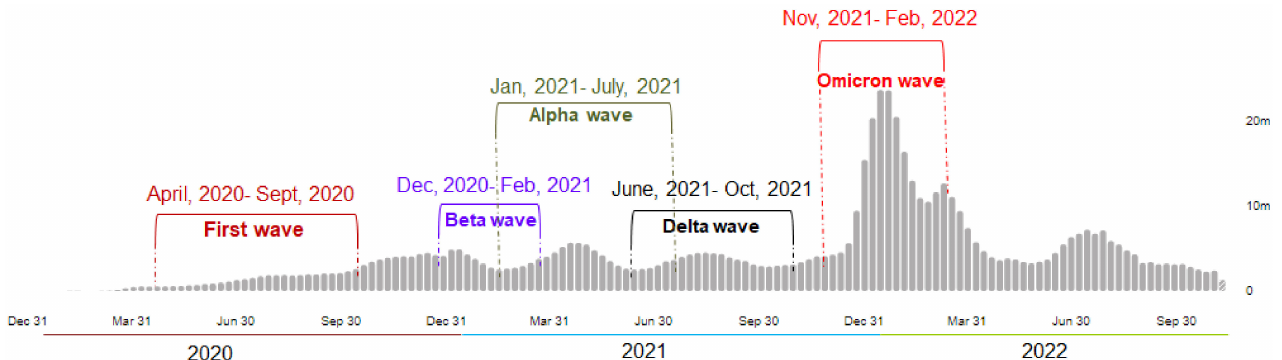
Figure 1. A timeline describes the origin of SARS-CoV-2 Omicron and different times of origin of Omicron’s sub-variants.